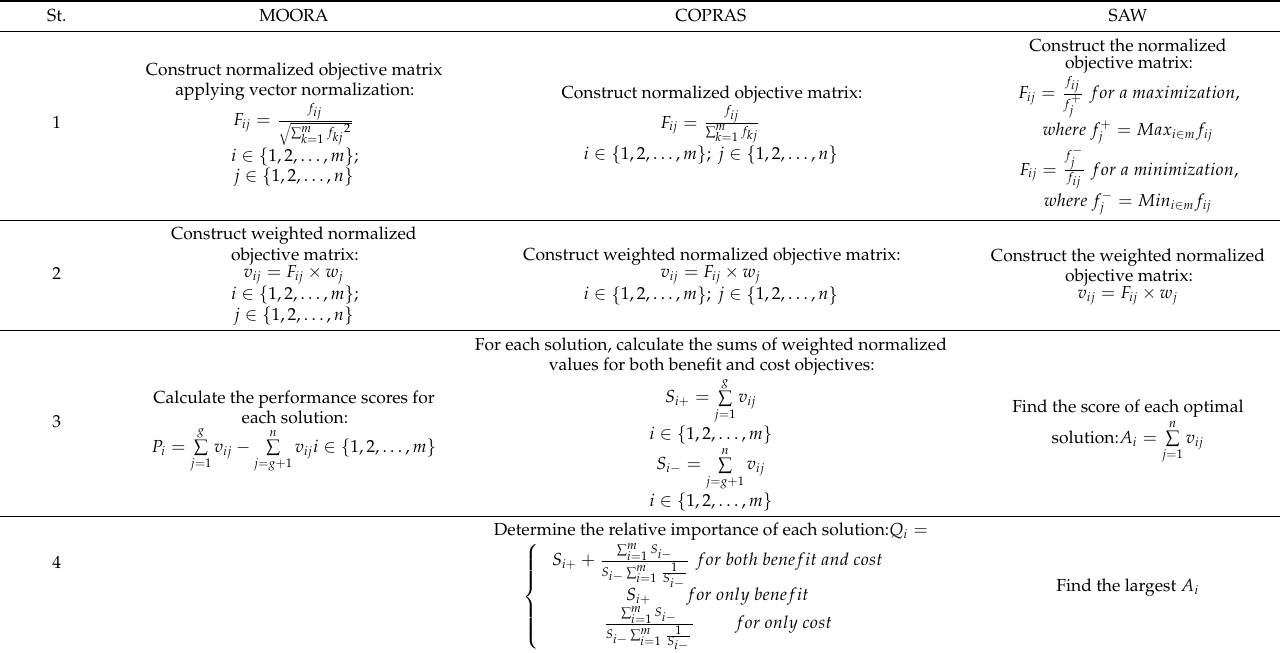
Table A2. Methodological Stages of MOORA, COPRAS and SAW. COPRAS SAW